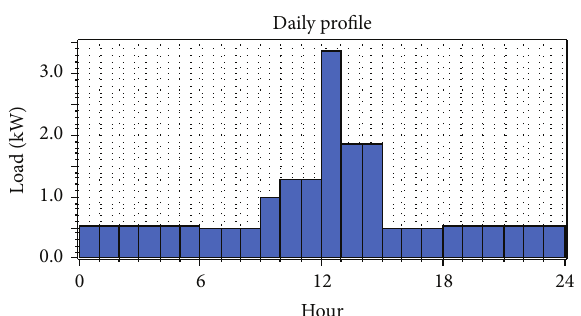
Figure 1: Daily load profile of the health clinic (load